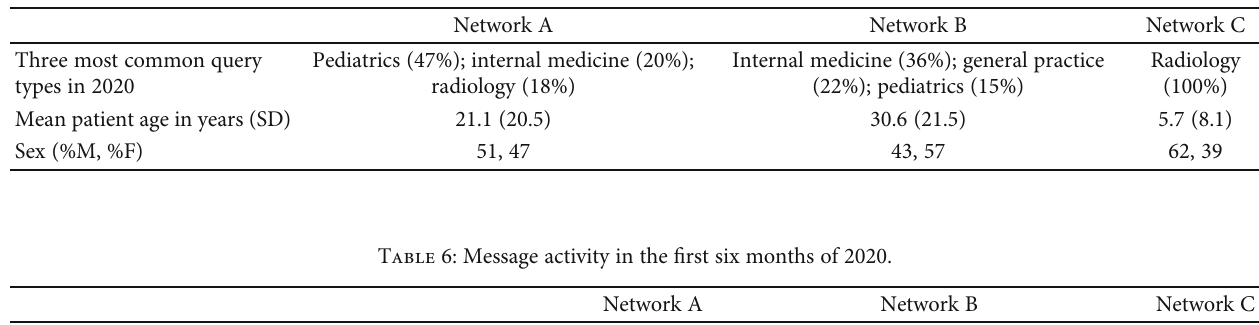
Figure 1: (a) Types of query for the cases on network A for the fi rst six months of 2018, 2019, and 2020. (b) Types of queries for the cases on network B for the fi rst six months of 2018, 2019, and 2020. Table 5: Case-mix in the fi rst six months of 2020.